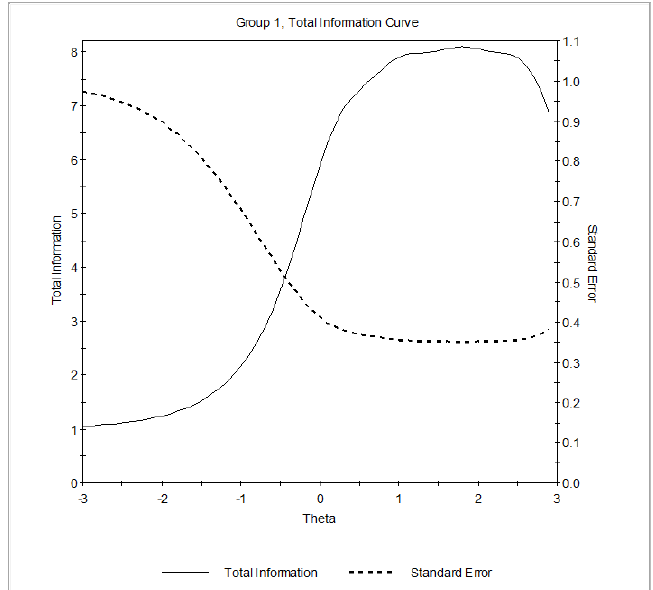
Figure 1. Test information function (TIF) of the BFAS under the graded response model (GRM). Latent trait ( θ ) is shown on the horizontal axis, and the amount of information and the standard error yielded by the test at any trait level are shown on the vertical axis.